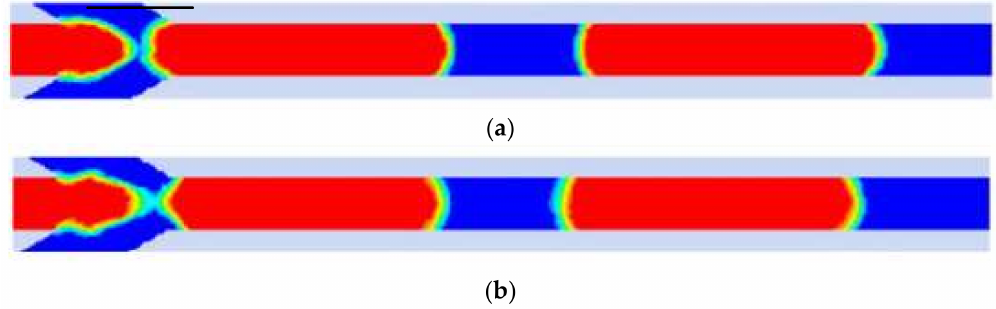
Figure 8. Comparison between ( a ) VOF Coupled with Level Set Method (CLSVOF) method ( b ) and VOF method. The interface in ( a ) is smoother than that in ( b ). Reprinted with permission from